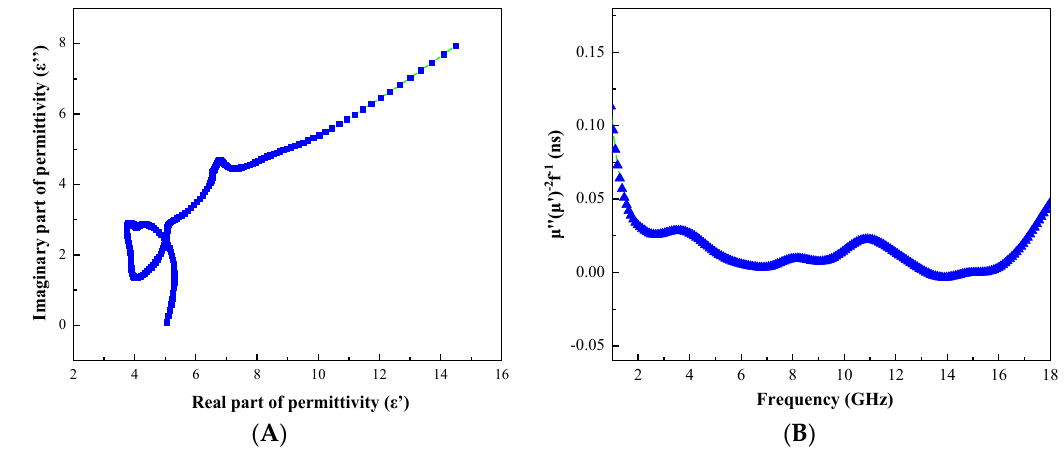
(cid:48) ( A ) and µ ”( µ ) (cid:48)− 2 f − 1 versus frequency ( B ) of dielectric Figure 11. Plots of ε '' versus ε ' ( A ) and μ ''( μ )' − 2 f − 1 versus frequency ( B ) of dielectric constant. Figure 11. Plots of ε ” versus ε